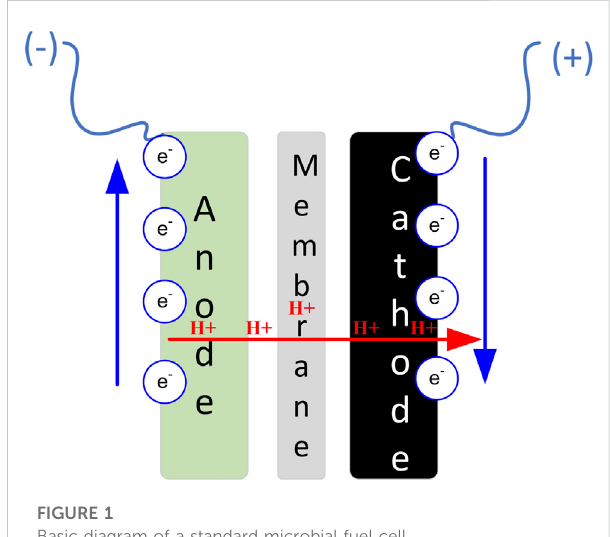
FIGURE 1 Basic diagram of a standard microbial fuel